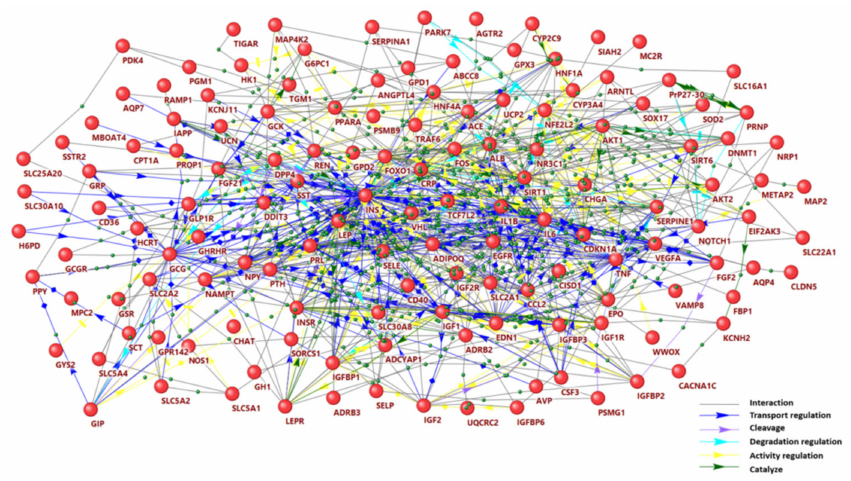
Figure 1. Molecular network of hypoglycemia visualized with the ANDSystem. The network of hypoglycemia consisted of molecules with different structures and functions. It included insulin and other hormones, cytokines and growth factors, enzymes, transporters, transcription factors, neuropeptides, structural and binding proteins, and microRNAs (Table